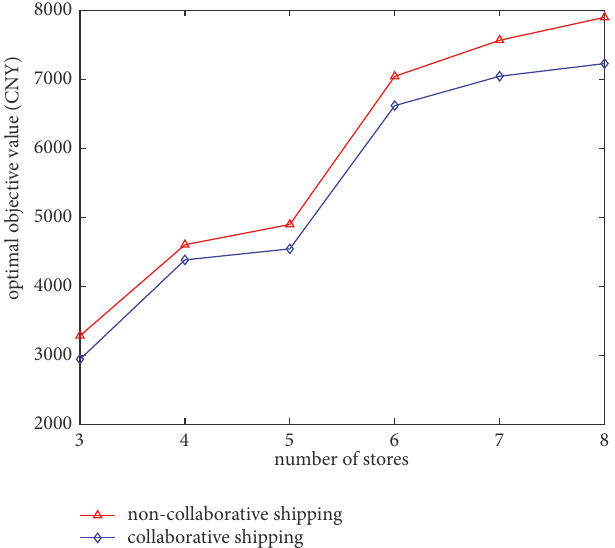
Figure 4: Optimal objective value under different number of stores and whether to carry out collaborative